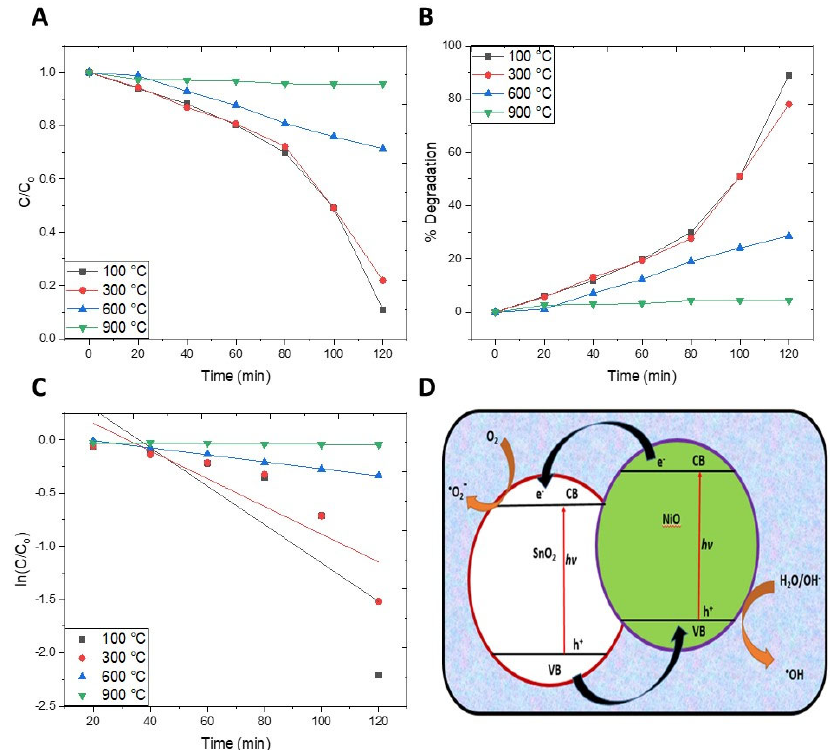
Figure 7. ( A ) Degradation profile, ( B ) percentage degradation, ( C ) kinetic isotherms/rate constant, and ( D ) schematic mechanism of photodegradation of MO in the presence of NiO-SnO 2 NCs calcined at the indicated temperature.